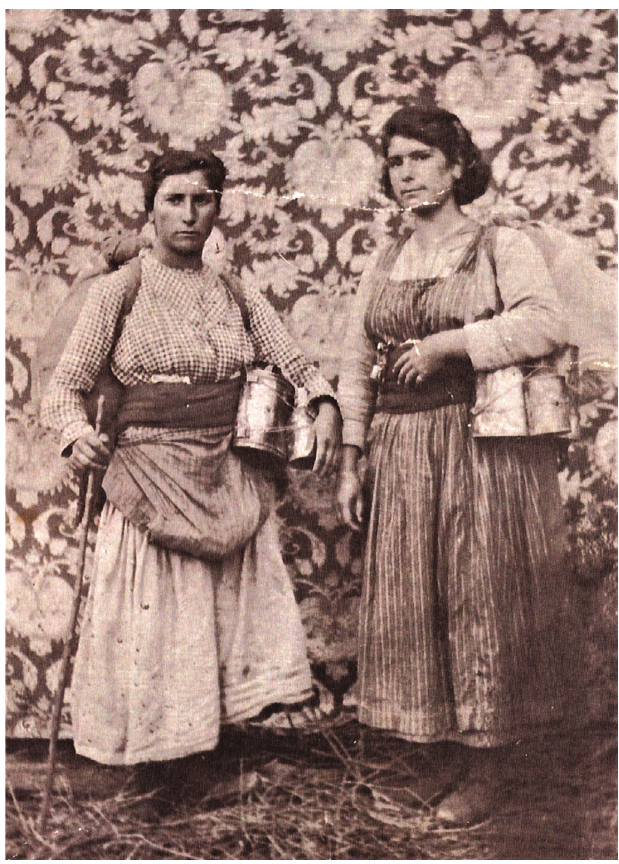
Figure 1: Trementinaires from the valley of La Vansa and Tuixent, photography © Museu de les Trementinaires, Tuixent, Lleida,